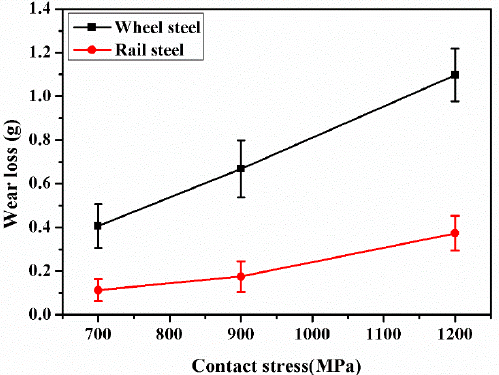
Figure 5. The variation of the wear loss of wheel and rail samples under different contact stress conditions.